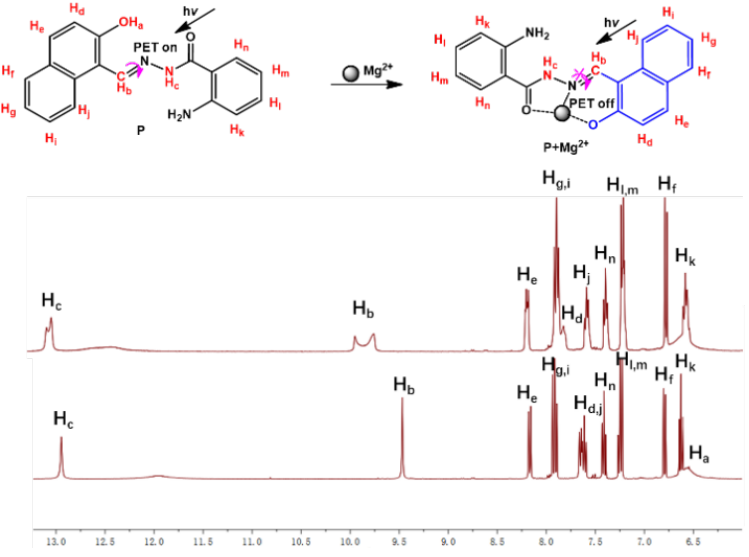
Figure 5. Proposed reaction mechanism of P with Mg 2+ .